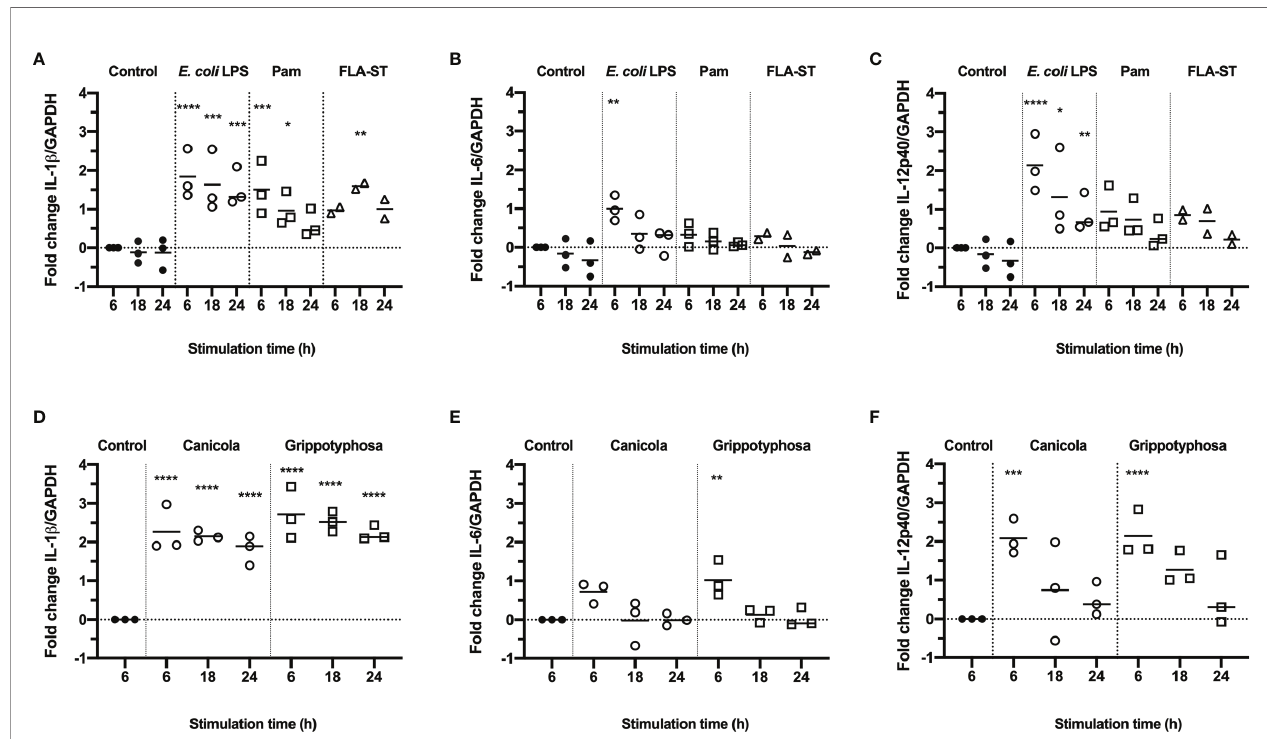
FIGURE 1 | Production of in fl ammatory cytokines in canine moDC stimulated with TLR agonists and Leptospira . RT-qPCR was performed on mRNA from canine moDC stimulated for 6, 18 and 24 h with TLR agonists E. coli LPS, Pam3CSK4 (Pam) or fl agellin (FLA-ST) (A – C) or whole-inactivated L. interrogans serogroup Canicola or L. kirschneri serogroup Grippotyphosa (D – F) . IL-1 b (A, D) , IL-6 (B, E) , and IL-12p40 (C, F) gene expression was normalized to GAPDH and fold change in expression relative to the unstimulated control (Control; t=6) is shown. Data represent mean values from three independent experiments. Each experiment was performed using two replicates per condition. A mixed-effect analysis combined with Dunnett ’ s multiple comparisons test was used to test for statistical signi fi cance between the stimulated sample and unstimulated control at 6 h; *p < 0.05, **p < 0.01, ***p < 0.001, ****p <